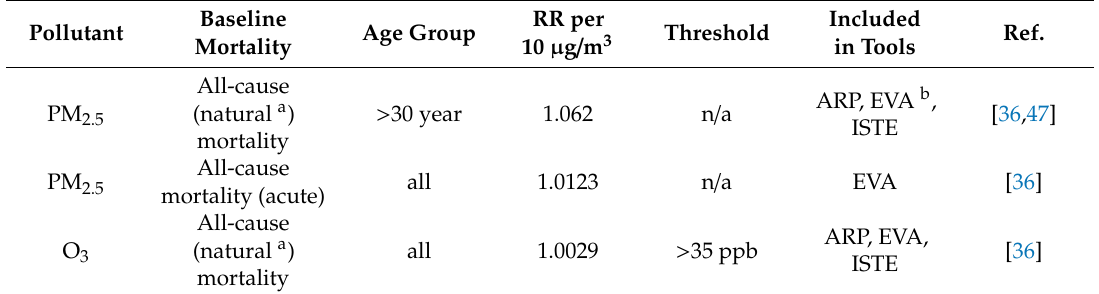
Table 3. Concentration-response functions used in the tool comparison.